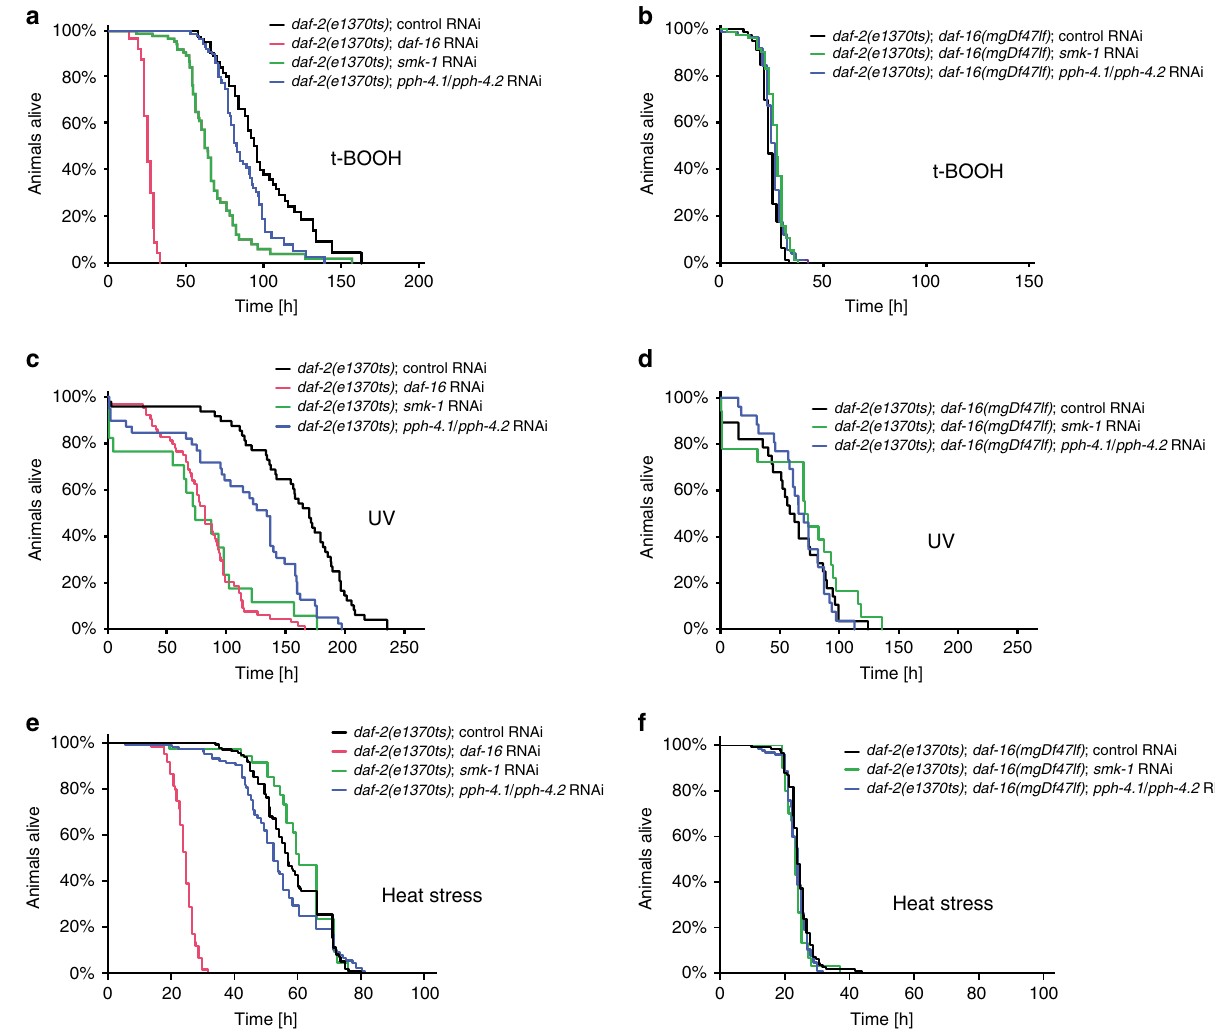
Fig. 3 Under low IIS, PP4 SMK-1 is required for DAF-16-mediated resistance to oxidative stress and UV. Stress survival phenotypes caused by loss of daf-16 or PP4 SMK-1 in various genetic backgrounds. Animals of indicated genotypes were grown at 15 °C from the L1 stage on the indicated RNAi bacteria. At the L4 stage the temperature was shifted to 25 °C to fully inactivate daf-2(e1370ts) . On day 2 adulthood, animals were then transferred to 6 mM tBOOH containing RNAi plates (oxidative stress), exposed to 1500 J/m 2 UV light (UV stress), or shifted to 32 °C (heat stress). All strains used in in this fi gure harbored the eri-1(mg366ts) mutation to yield better knockdown ef fi ciencies 51 . a , c Loss of PP4 SMK-1 , either by knockdown of SMK-1 or double knockdown of PPH-4.1/PPH-4.2, impaired the enhanced survival of daf-2(e1370ts) mutant animals that were exposed to oxidative stress ( a ) or UV stress ( c ). b , d These phenotypes were abolished in the absence of daf-16 . e , f In contrast to oxidative stress and UV stress, loss of these PP4 SMK-1 subunits did not impair the enhanced survival of daf-2(e1370ts) mutant animals exposed to heat stress. For detailed statistics see Supplementary Table 4. Source data are provided as a Source Data fi